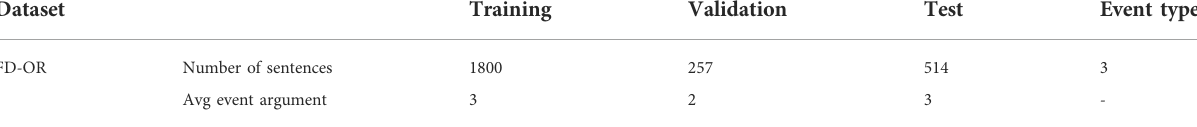
TABLE 2 Experimental dataset.